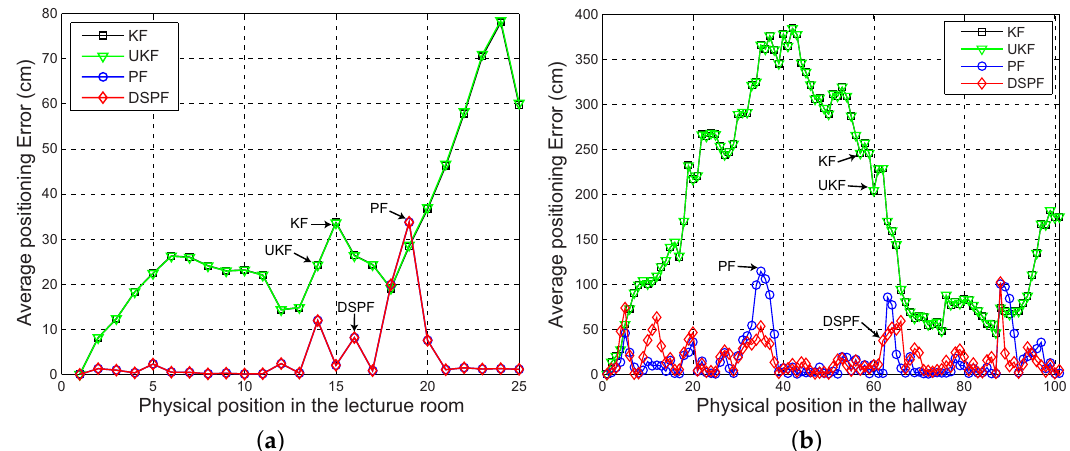
Figure 7. Mean positioning error for the localization scheme in which the Bayes filters are performed by DRC3 at each physical location (orange circle and green square in Figure 4) of test cases ( a ) TC1 and ( b ) TC2.